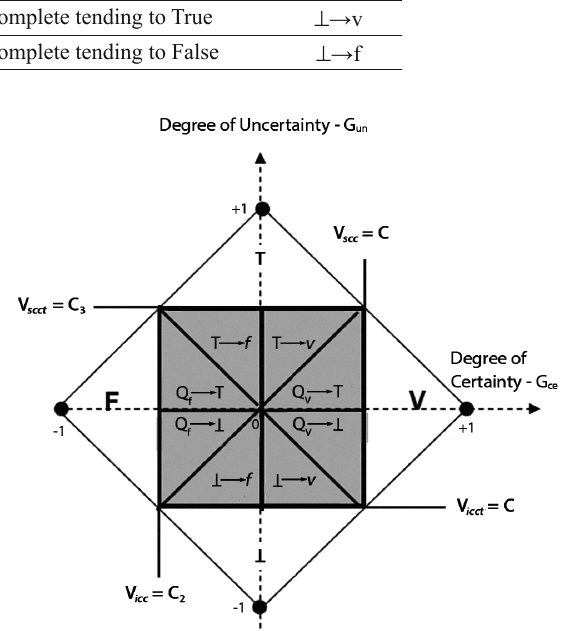
Figure 1 - Extreme and Non-extreme